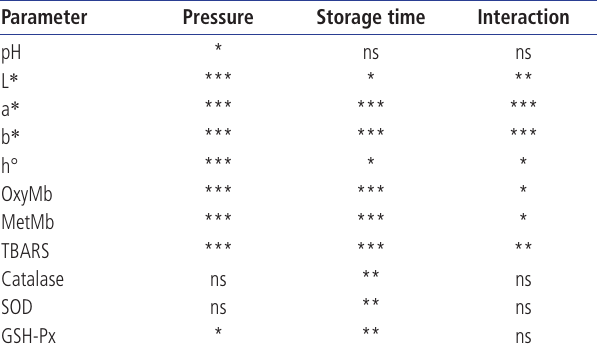
Table 2. The effects of different levels of pressure and storage period on meat pH, TBARS, instrumental surface color, myoglobin relative proportion and